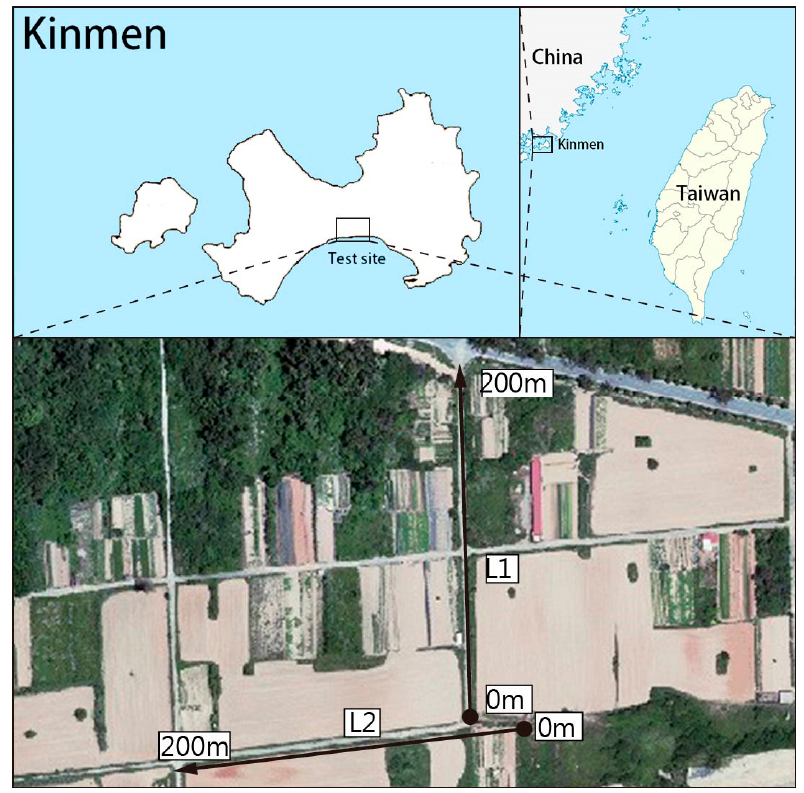
Figure 3. Location diagram of Shangyi Village and laying of lateral lines.